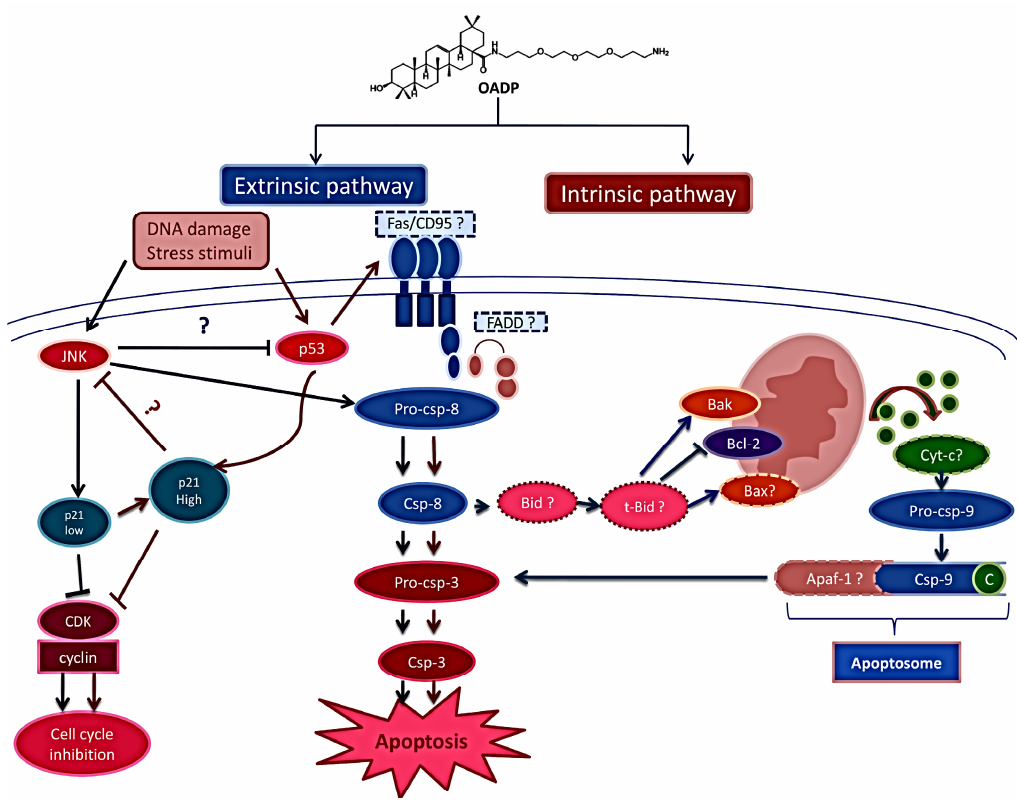
Figure 9. Mechanism of action underlying apoptosis induced by OADP in HepG2 cells after 72 h of treatment, at IC 50 and IC 80 concentrations, alone, and IC 50 concentrations combined with the JNK inhibitor (SP600125). Dark blue arrows represent IC 50 apoptotic pathway, and dark red arrows represent apoptotic pathways associated with the IC 80 concentration and the IC 50 concentration in combination with the JNK inhibitor